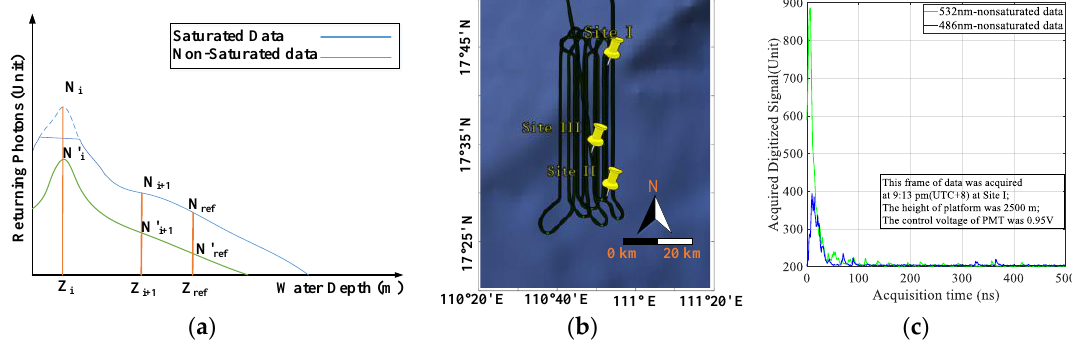
Figure 7. ( a ) Diagram of the non-saturated value reference (NSVR) method; ( b ) distribution of sites for capturing characteristic data; ( c ) non-saturated data for the 532- and 486 nm channels.